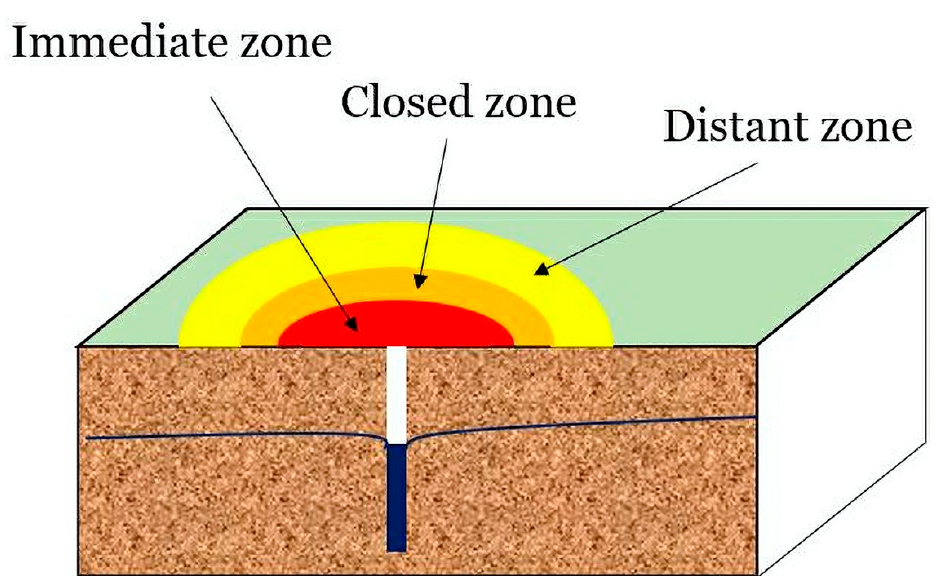
Figure 1. Schematic representation of the different protection buffer zones of a groundwater borehole (adapted from [39]).